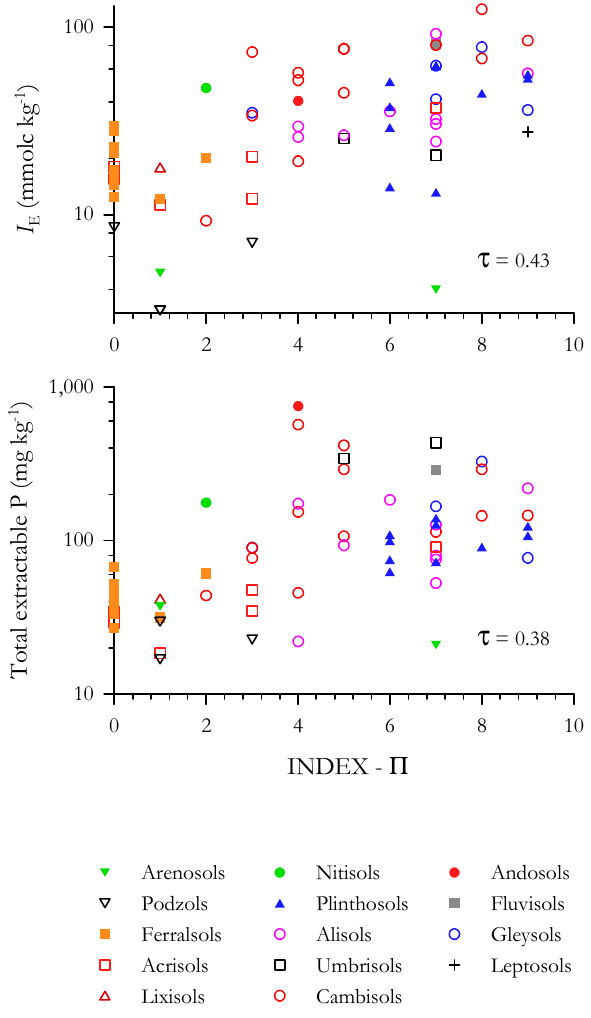
Fig. 15. Trade off between soil element concentrations and limiting physical properties. Effective cation exchange capacity ( I E , top) and total extractable phosphorus (below) co-vary with soil physical limitations. Values of Kendall’s τ rank correlation coefficient are also